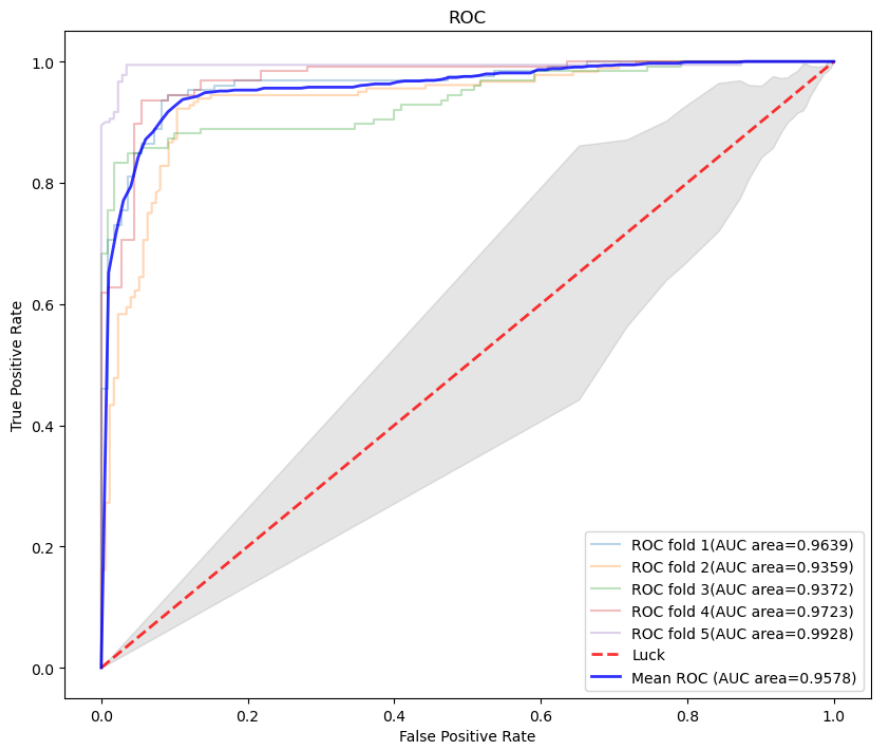
Figure 5. ROC curve and corresponding AUC value of Bidirectional Encoder Representation from Transformers (BERT) model. Notes: ROC: the receiver operating characteristic curve; AUC: area